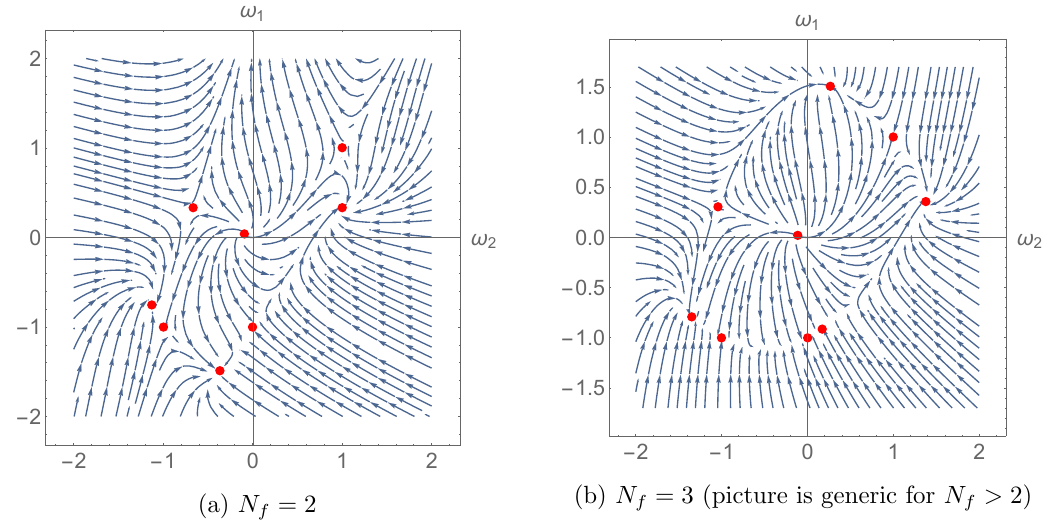
Figure 18. Fixed points in terms of !